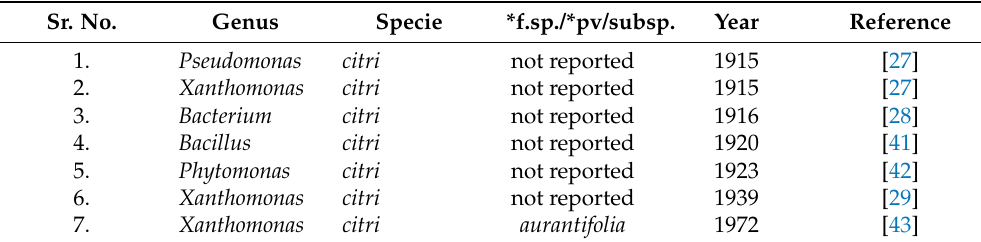
Table 1. Citrus canker bacterium A strain classification details, from the start of the studies. Sr.